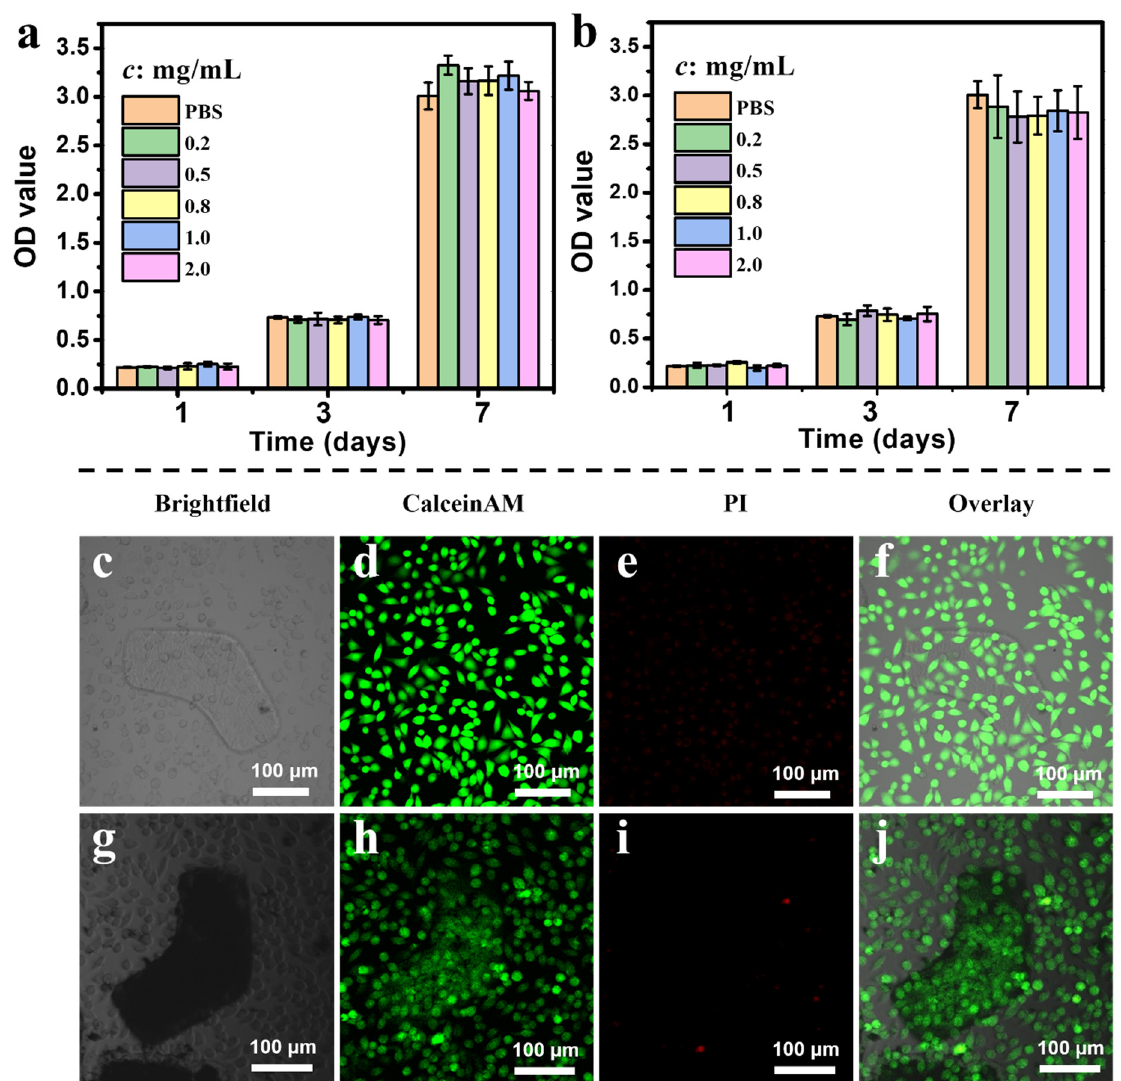
Figure 7. L929 viability of ( a ) smashed top layer material and ( b ) smashed microrobot material after 1, 3, and 7 days of incubation (Error bars represent standard deviations. c refers to concentrations of material dispersed in PBS). Fluorescence microscopy images of L929 cells stained by CalceinAM/PI dyes after co-cultured with the material from the top layer ( c – f ) and microrobots ( g – j